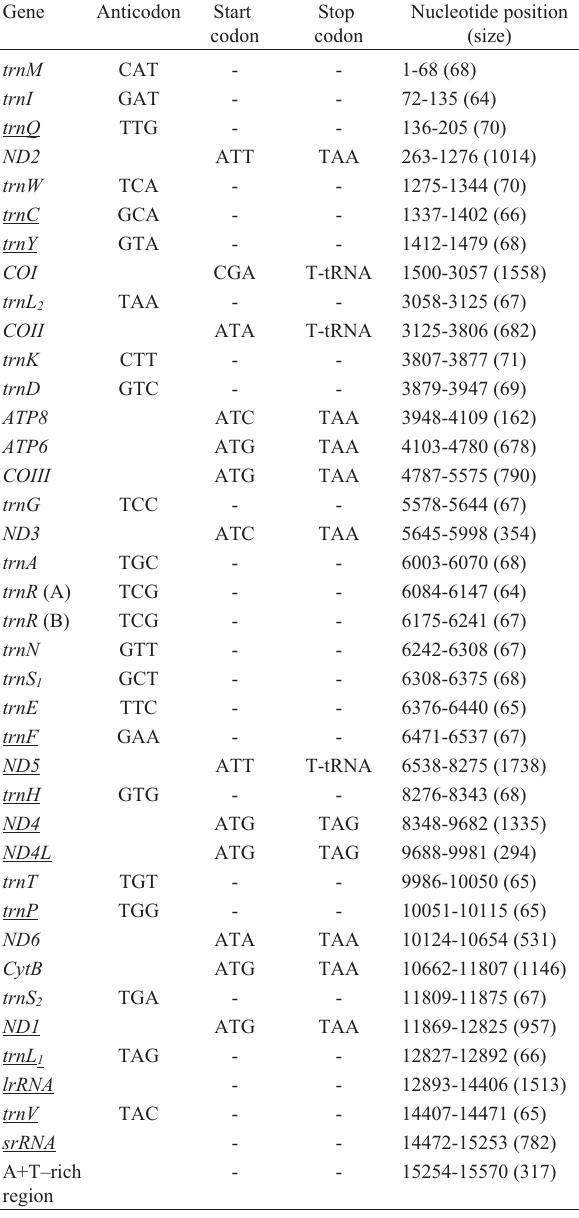
tRNA abbreviations follow the IUPAC-IUB three letter code. -, not